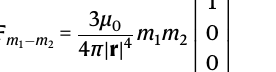
corresponding magnetic fi eld directions. c Demonstration of the use of the MaSoChain endoscope with both the fi xed lab camera view (upper row) and the onboard endoscope cameraview (lower row).The scale baris25mm. The process included complete assembly of the three-segment capsule endoscope, magnetic navigation of the capsule, locking on the target, insertion of biopsy forceps, per- forming biopsy, and retraction of the capsule. The complete experiment can be found in Supplementary Movie